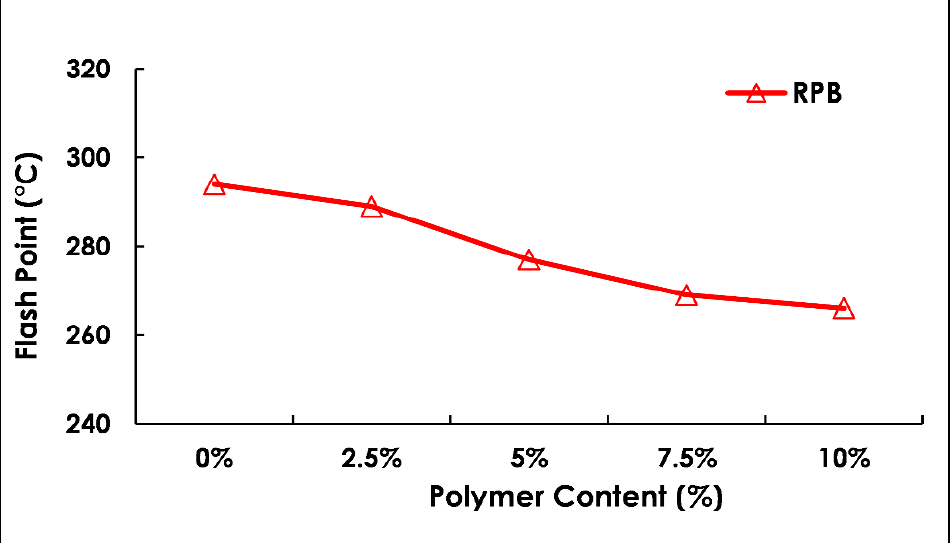
Figure 10. Flash point test results with varying polymer content (%).